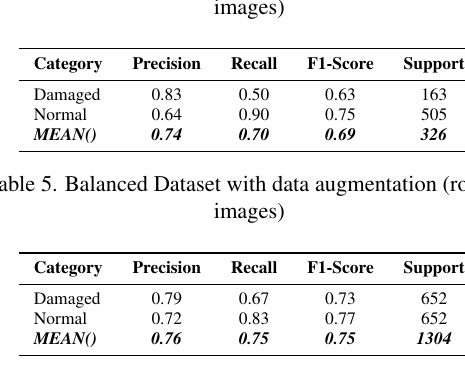
Table 6. Balanced Dataset with data augmentation (flipped and rotated images)